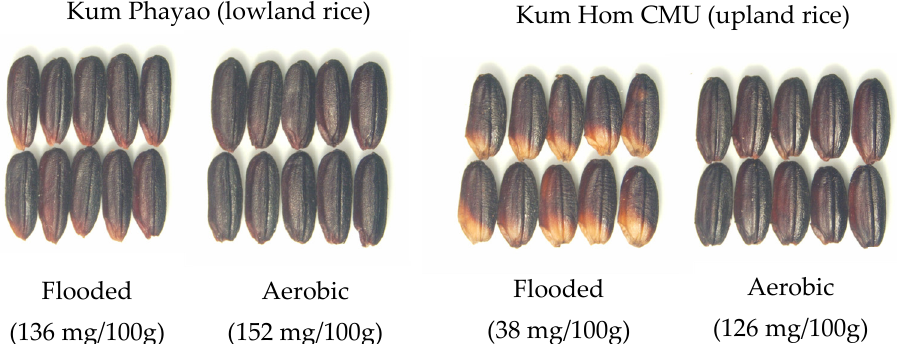
Figure 5. The responses of two purple rice varieties, cv. Kum Phayao (lowland rice) and Kum Hom CMU (upland rice), to flooded and aerobic soil conditions (the total anthocyanin concentrations are provided in the brackets).